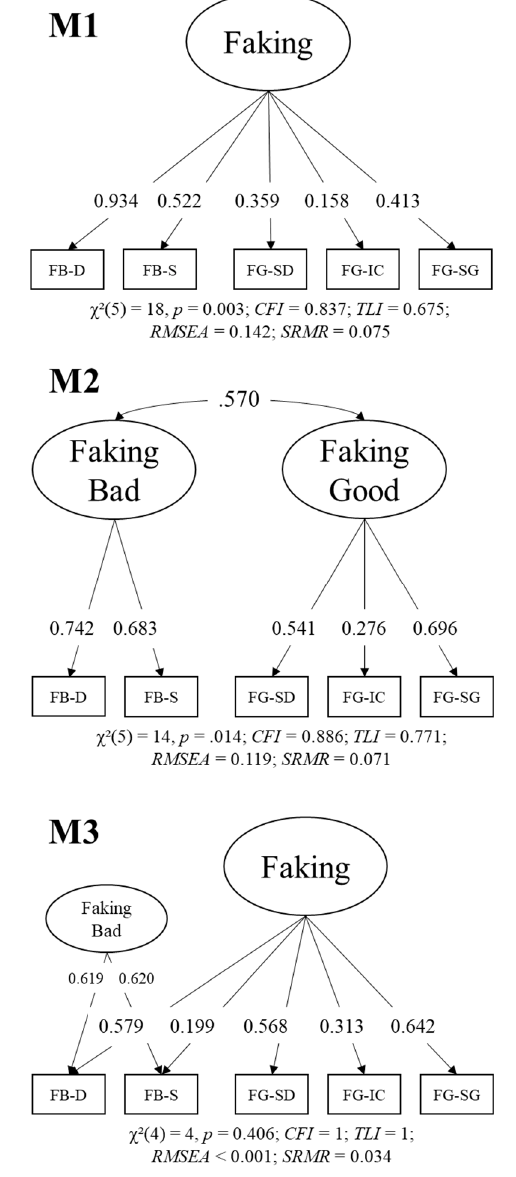
Figure 1. Measurement models of faking ability. FB = faking bad; FG = faking good, D = depression, S = somatization; SD = software developer; IC = insurance policy processing clerk; SG = security guard. Loadings are standardized